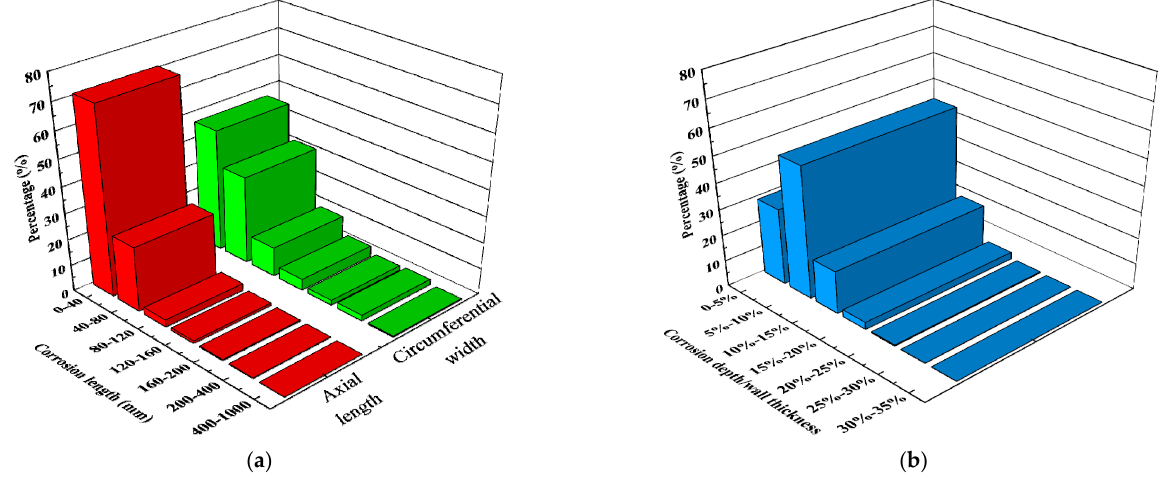
Figure 1. The external metal loss defect size distribution of a pipeline: ( a ) corrosion length, ( b ) cor- rosion depth.